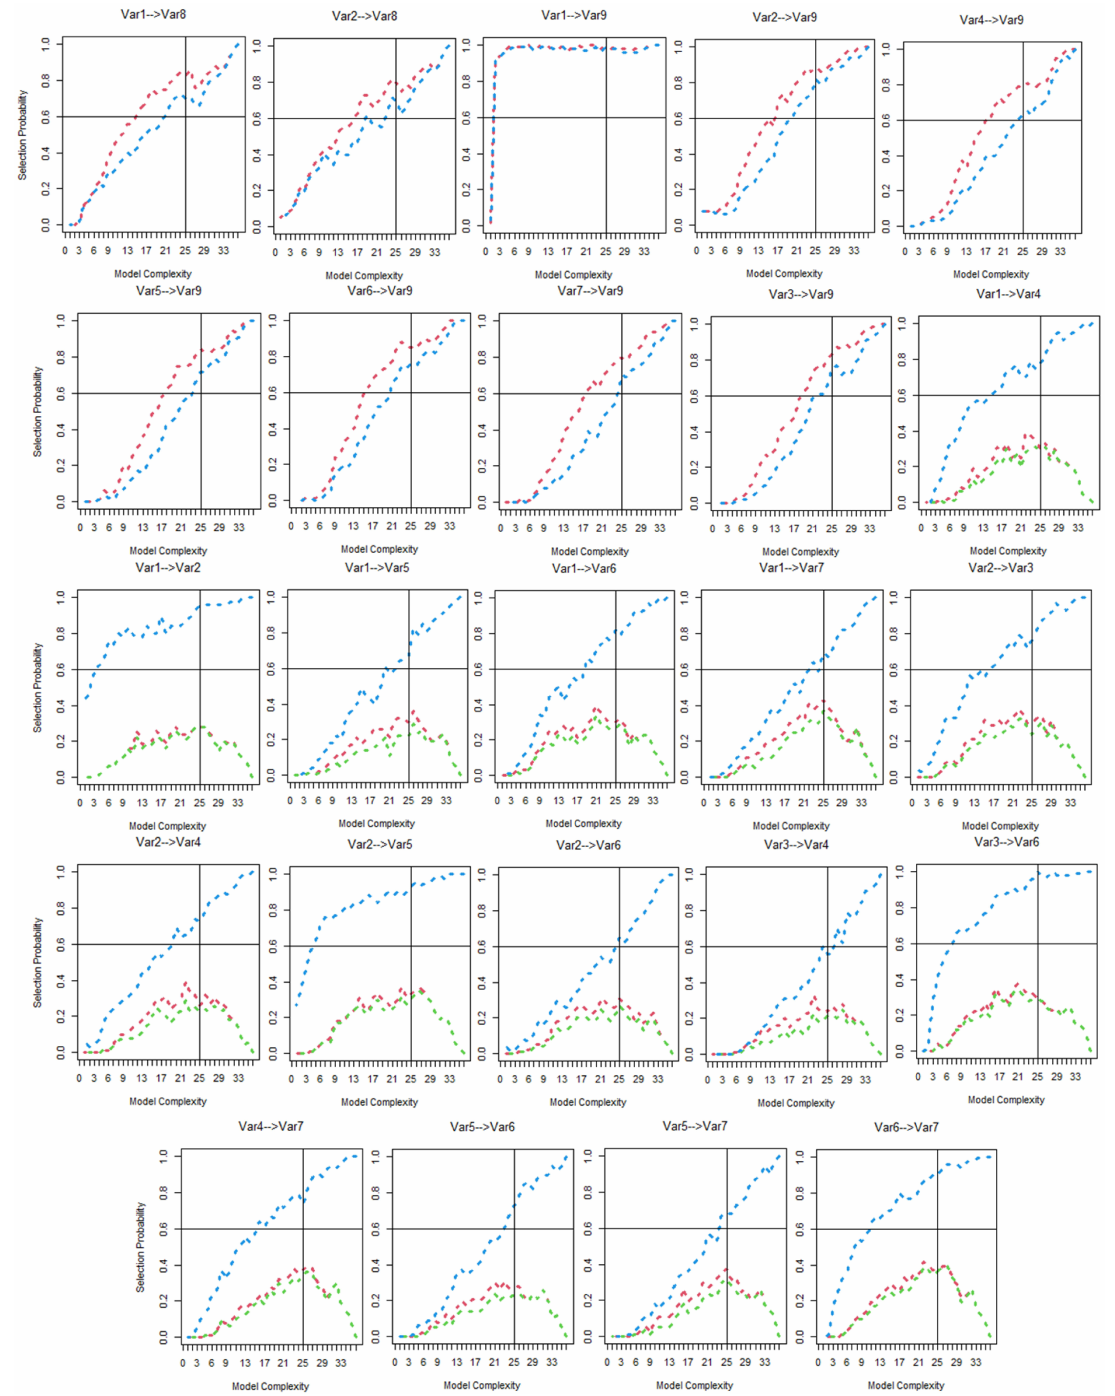
Fig. 4 The stability graphs with the descriptions of variable as follows: var1 physical, var2 emotional, var3 nausea-voming, var4 dyspnea, var5 insomnia, var6 loss of appetite, var7 constipation, var8 global healt status/QoL, var9 performance status Based on the stability graphs on Fig. 3 and Fig . 4 , Fig. 5 visualizes the relevant edge and causal paths. Each relation has a reliability score, which shows the likelihood/probability of the selection, i.e., the higher the score, the